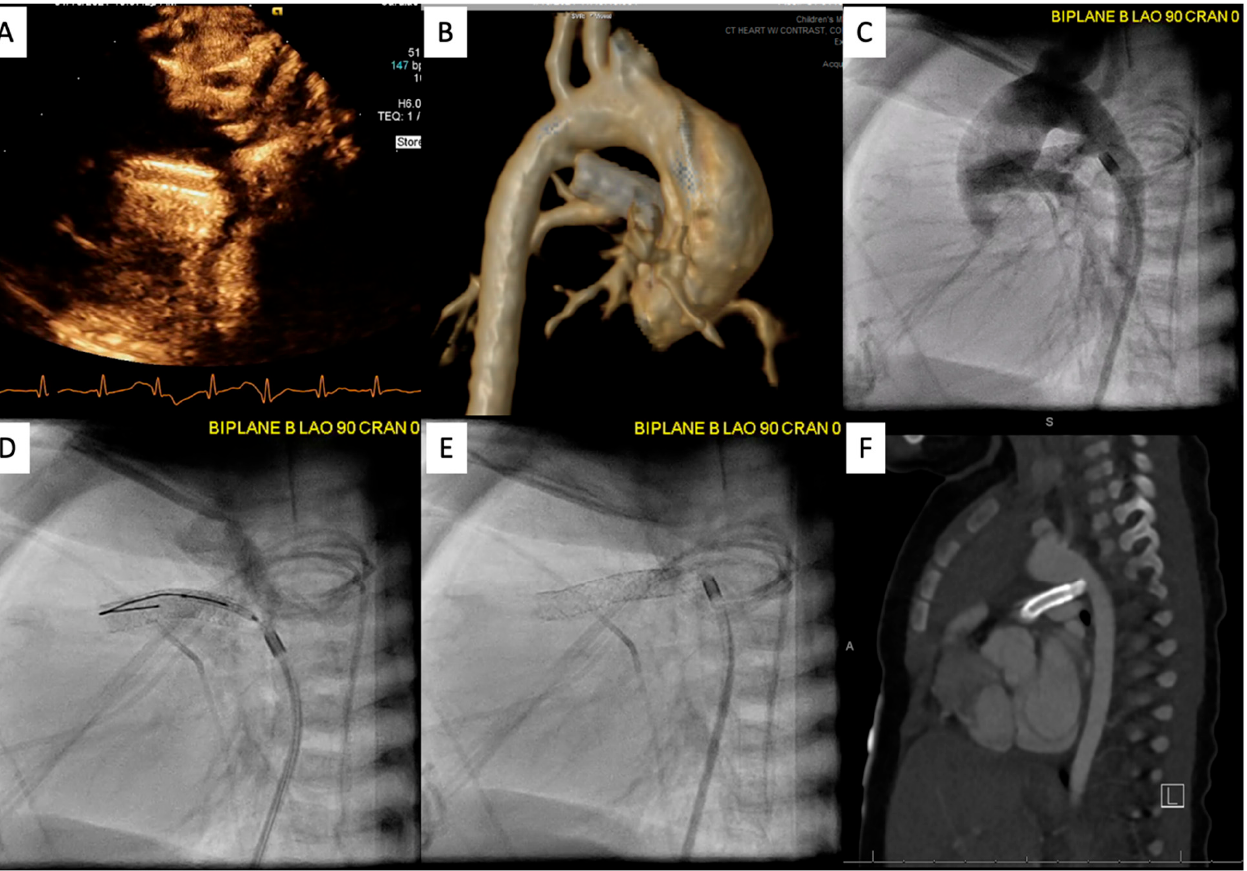
Figure 10. Patient is status post PDA stenting with concern for cyanosis. ECHO/CT scan demon- strated that the aortic end was uncovered ( A , B ). Patient returned to the catheterization lab for an additional stent placement ( C – E ). Follow up PDA stenting showed full coverage ( F ).